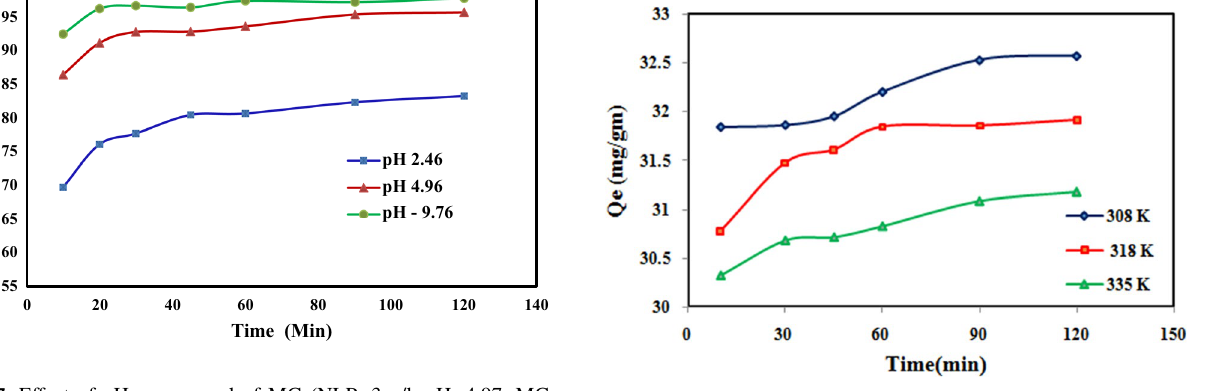
Fig. 7 Effect of pH on removal of MG (NLP: 3 g/l, pH: 4.97, MG: 100 mg/l, Temp: 300 K)